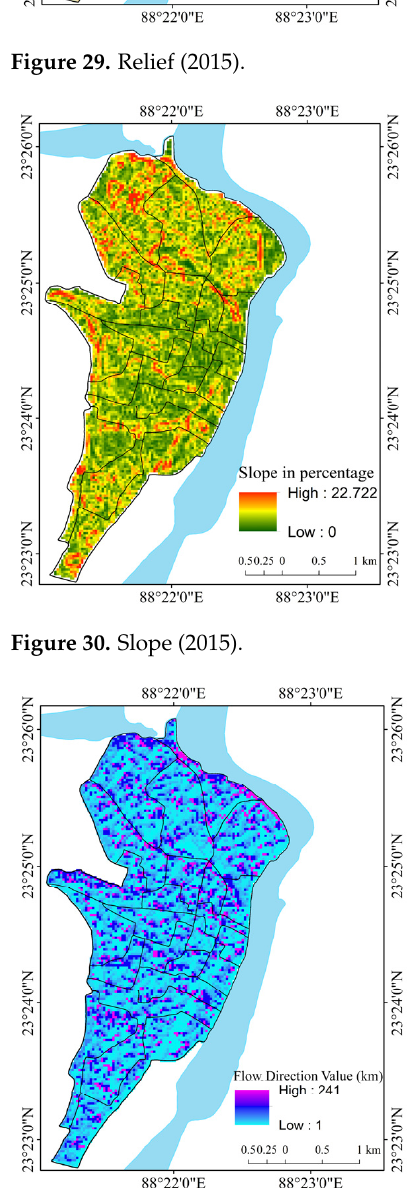
Figure 32. Flow distance (2015). Figure 33. Flow length (2015).